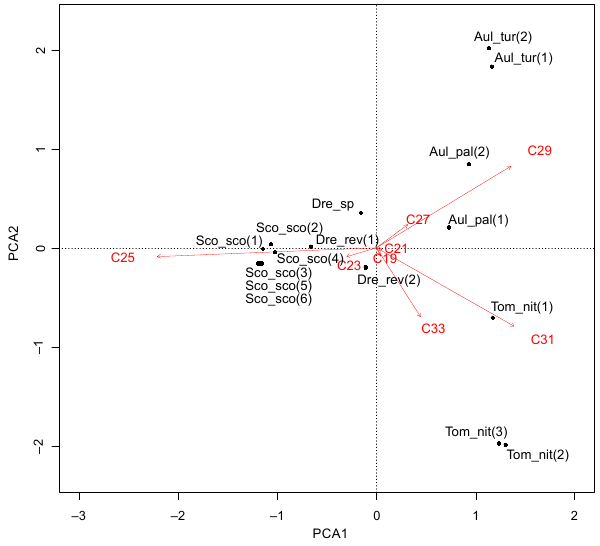
Figure 5. PCA of n -alkanes separates the meso-hygrophilic group on the left side of axis 1 from the xero-mesophilic group on the right side. Along the second axis the Aulacomniaceae are distin- guished from Tomentypnum nitens according to the distribution of long-chain n -alkanes with more or less than 30 carbon